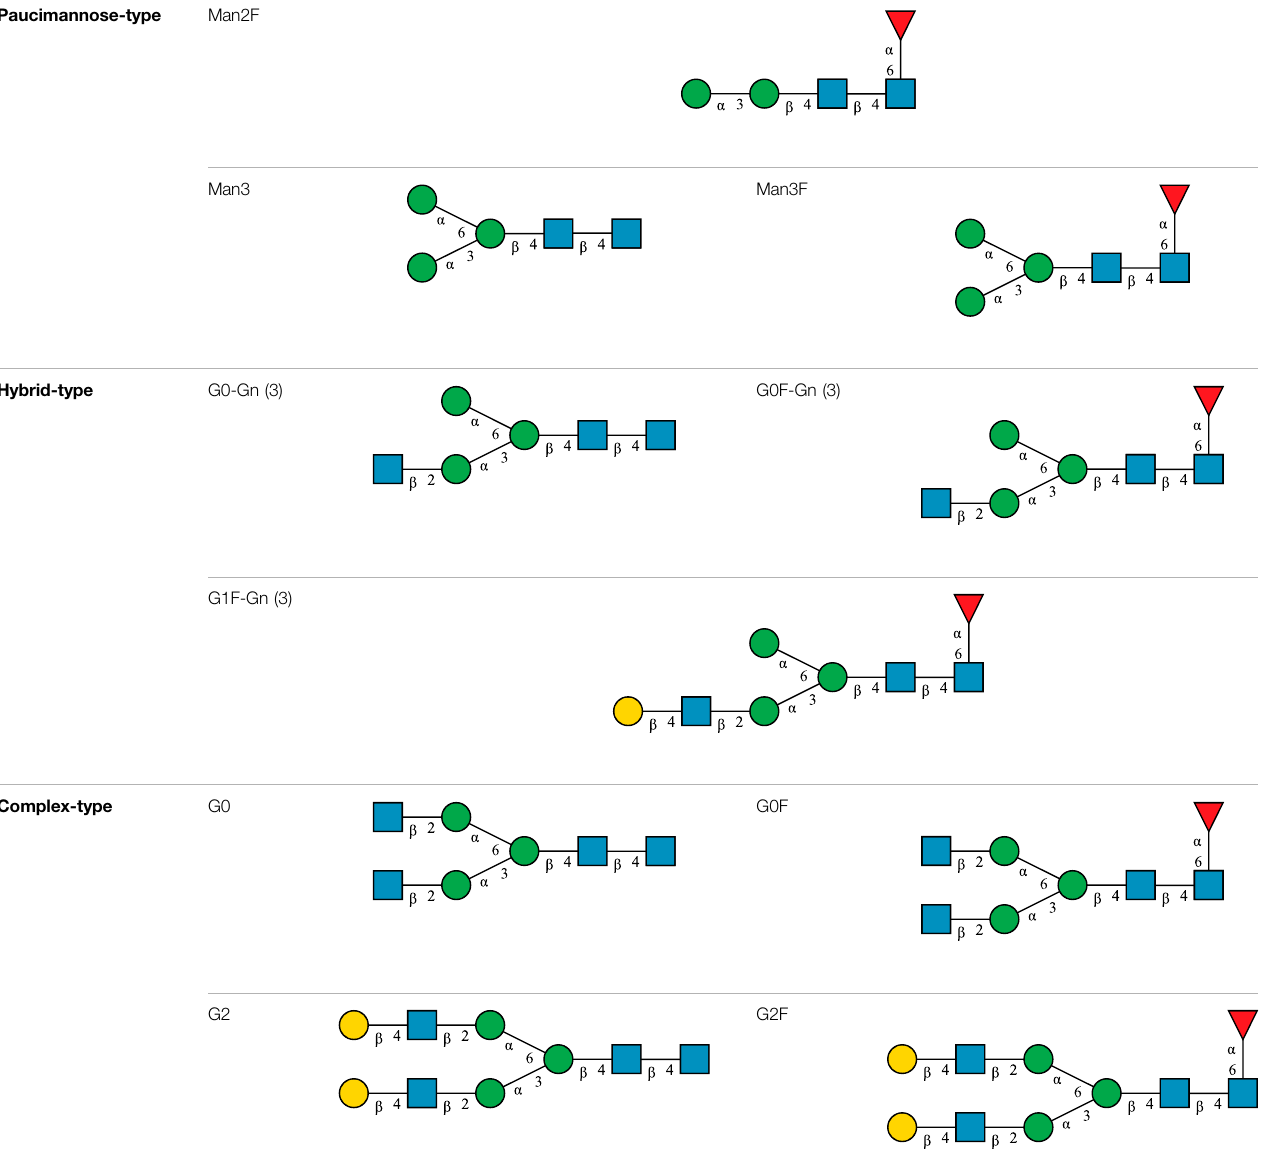
TABLE 1 | N-glycan categories and nomenclature for all detected and referenced structures with the exception of oligomannose-type N-glycans. The monosaccharide building blocks are mannose (green circle), GlcNAc (blue square), fucose (red triangle) and galactose (yellow circle).